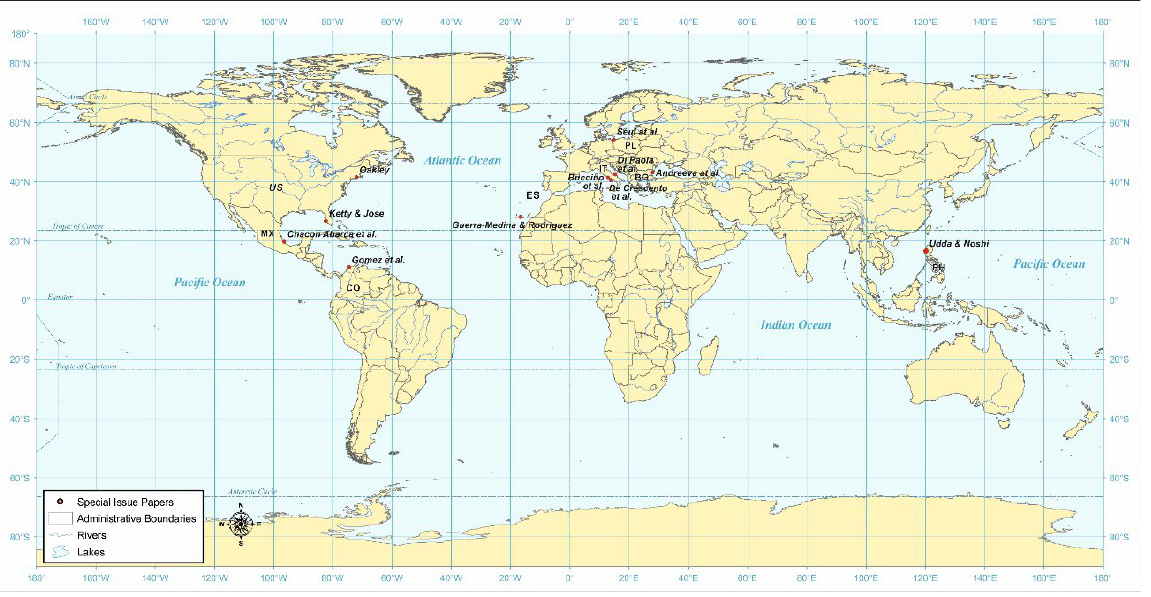
Figure 1. Geographical distribution of the contributions included in the Special Issue.